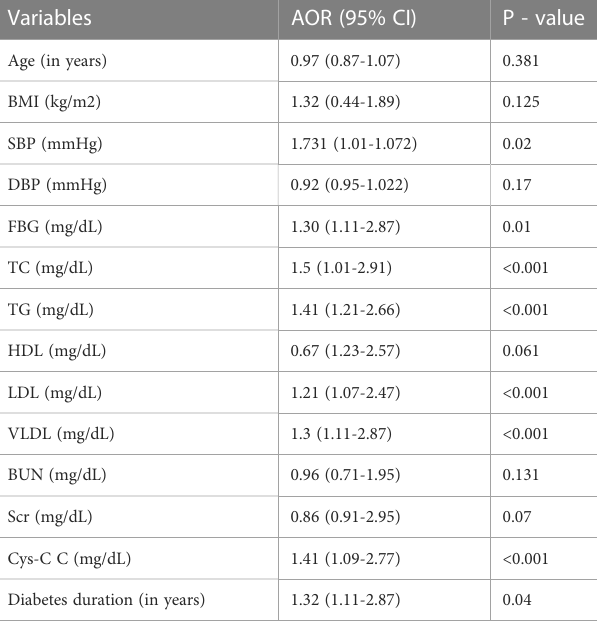
TABLE 2 Independent factors for predicting diabetic nephropathy in T2DM patients.